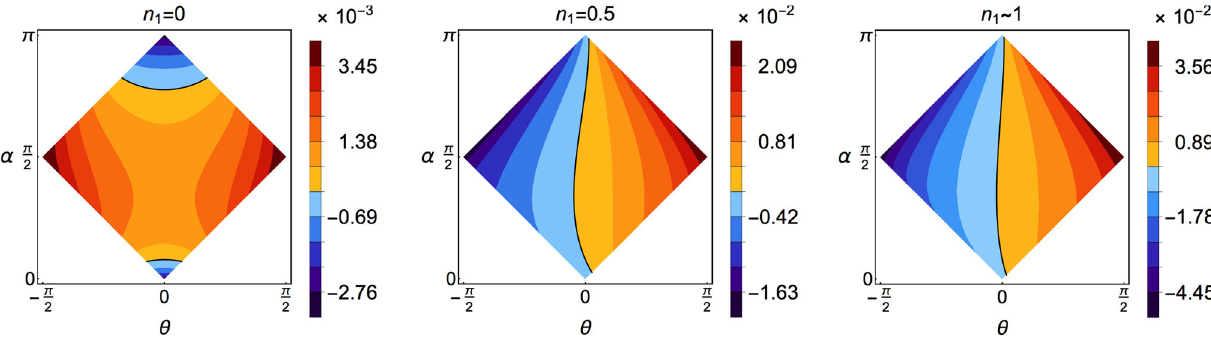
Fig. 11 Pressure in the α − θ plane for different values of n 1 . In these plots, T = 0 . 35 and L =